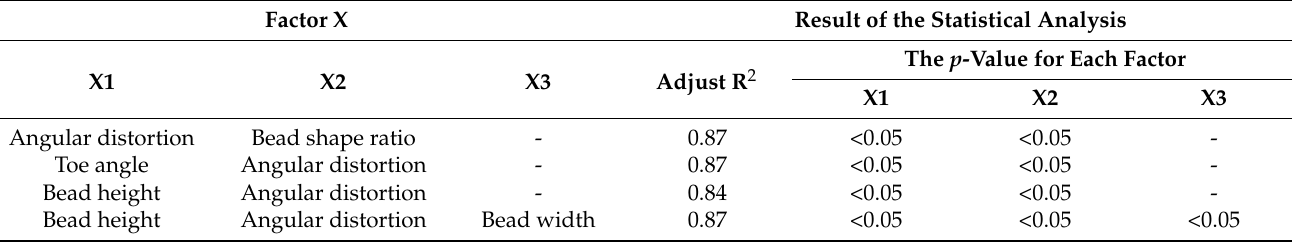
Table 9. Regression results for the weld bead profiles and the fatigue